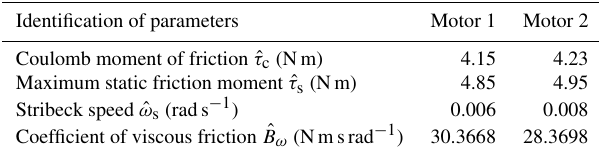
Figure 10. Curve of friction torque and rotational speed. Table 3. Parameter